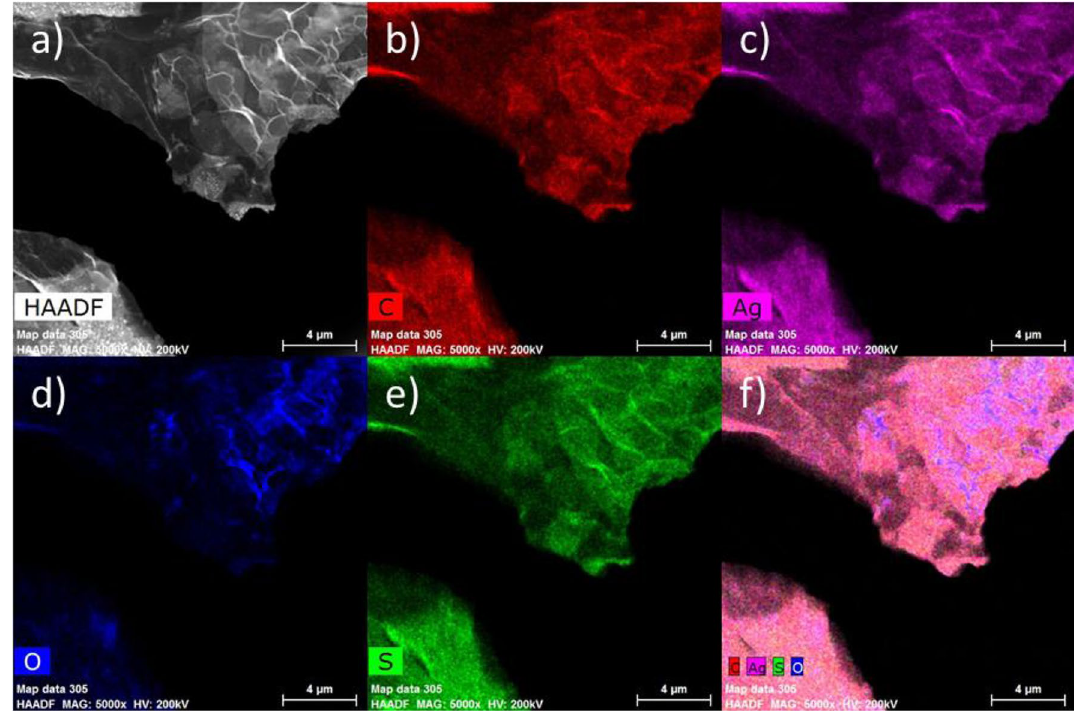
Figure 5. Elemental composition of the nanosheet structure created using n-hexane. ( a ) STM HAADF images of the nanosheet deposited on TEM grid. (b-e) Distribution of carbon ( b ), silver ( c ), oxygen ( d ) and sulfur ( e ). ( f ) the overlap mapping of the four elements (carbon, silver, sulfur, and oxygen).